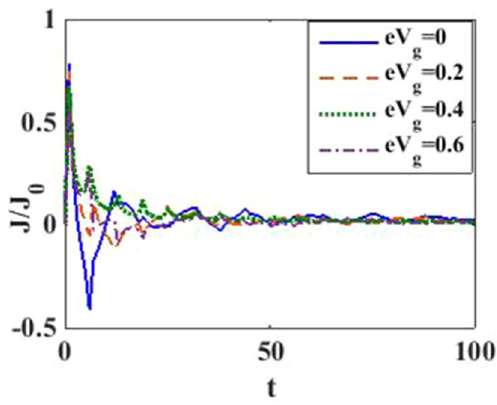
Figure 12. J / J 0 versus t for various values of eV g at (cid:31) = 0.6 .